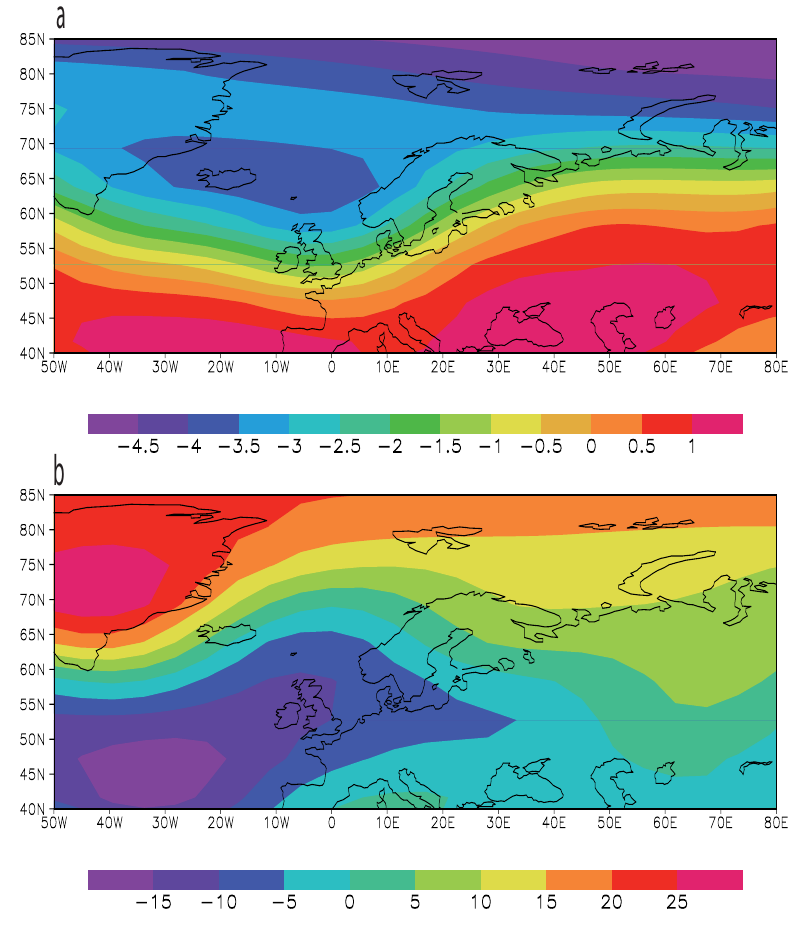
Fig. 2. (a) Difference in winter geopotential height ( m ) averaged over the 11 simulations using data assimilation between the periods 1401–1500 and 1601–1700. (b) Anomaly of winter geopotential height ( m ) averaged over the 11 simulations using data assimilation in the period 1790–1820 compared to the reference period 1850-1995.